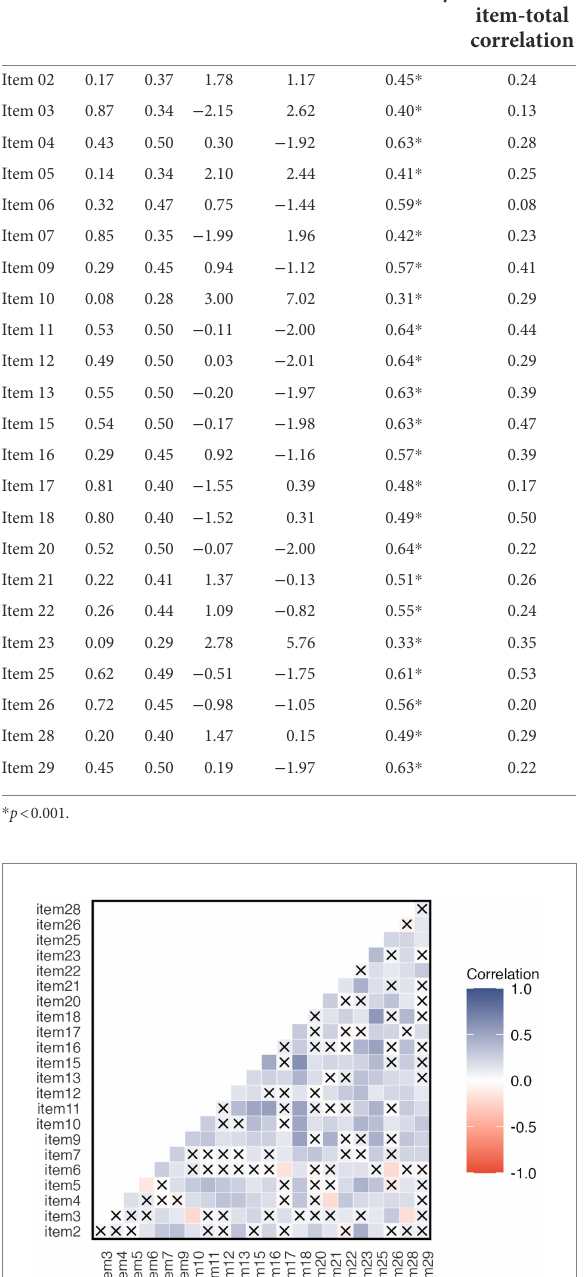
TABLE 1 Descriptive statistics of 23 items of Bangla Rotter’s I-E scale (Study 1, N = 300). Items Mean SD Skew Kurtosis Normality Corrected